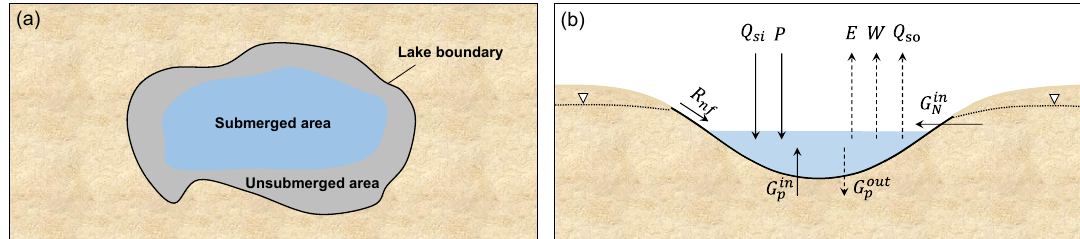
Figure 2. Conceptual models of the lake packages to be coupled with MODFLOW: ( a ) Plain view and ( b ) side view of a lake. Lakebed conceptualization using the ( c ) LAK3 method and ( d ) SLM method. For the SLM, 𝑃 is precipitation, 𝐸 is evaporation, 𝑊 is water withdrawal, 𝑄 (cid:3046)(cid:3036) is inflow from upstream rivers to the lake, 𝑄 (cid:3046)(cid:3042) is outflow from the lake to downstream rivers, 𝐺 (cid:3043)(cid:3036)(cid:3041) is inflow from groundwater to the lake in the submerged area, 𝐺 (cid:3043)(cid:3042)(cid:3048)(cid:3047) is outflow from the lake to groundwater in the submerged area, 𝑅𝑛𝑓 is the surface runoff generated in the unsubmerged area, 𝐺 (cid:3015)(cid:3036)(cid:3041) is groundwater seepage to the unsubmerged area. For LAK3, 𝑄 (cid:3045)(cid:3041)(cid:3033) is the surface runoff to the lake, and 𝑠𝑝 is the net seepage between the lake and the aquifer. 2.2.3. Model Setup Transient flow models were developed for Lake Hampen and its surrounding aquifer using LAK3 and the SLM as the lake package, each coupled with MODFLOW as the groundwater flow model. The northern, eastern and southern model boundary was de ‐ fined by the groundwater divide, so the no ‐ flow boundaries were defined in the north, east and south borders (Figure 3a). The western border of the model domain was defined as the general head boundary using the interpolated averaged head values from nearby wells measured throughout 2008. The geology was represented by five hydrogeologic units, namely, glacial sand, glacial clay, tertiary clay, tertiary sand and lake bottom sedi ‐ ments (Figure 3b–d). Four groundwater recharge zones were specified based on the un ‐ saturated zone thickness and land use (Figure 4). The recharge values for the four different zones were calculated by HYDRUS ‐